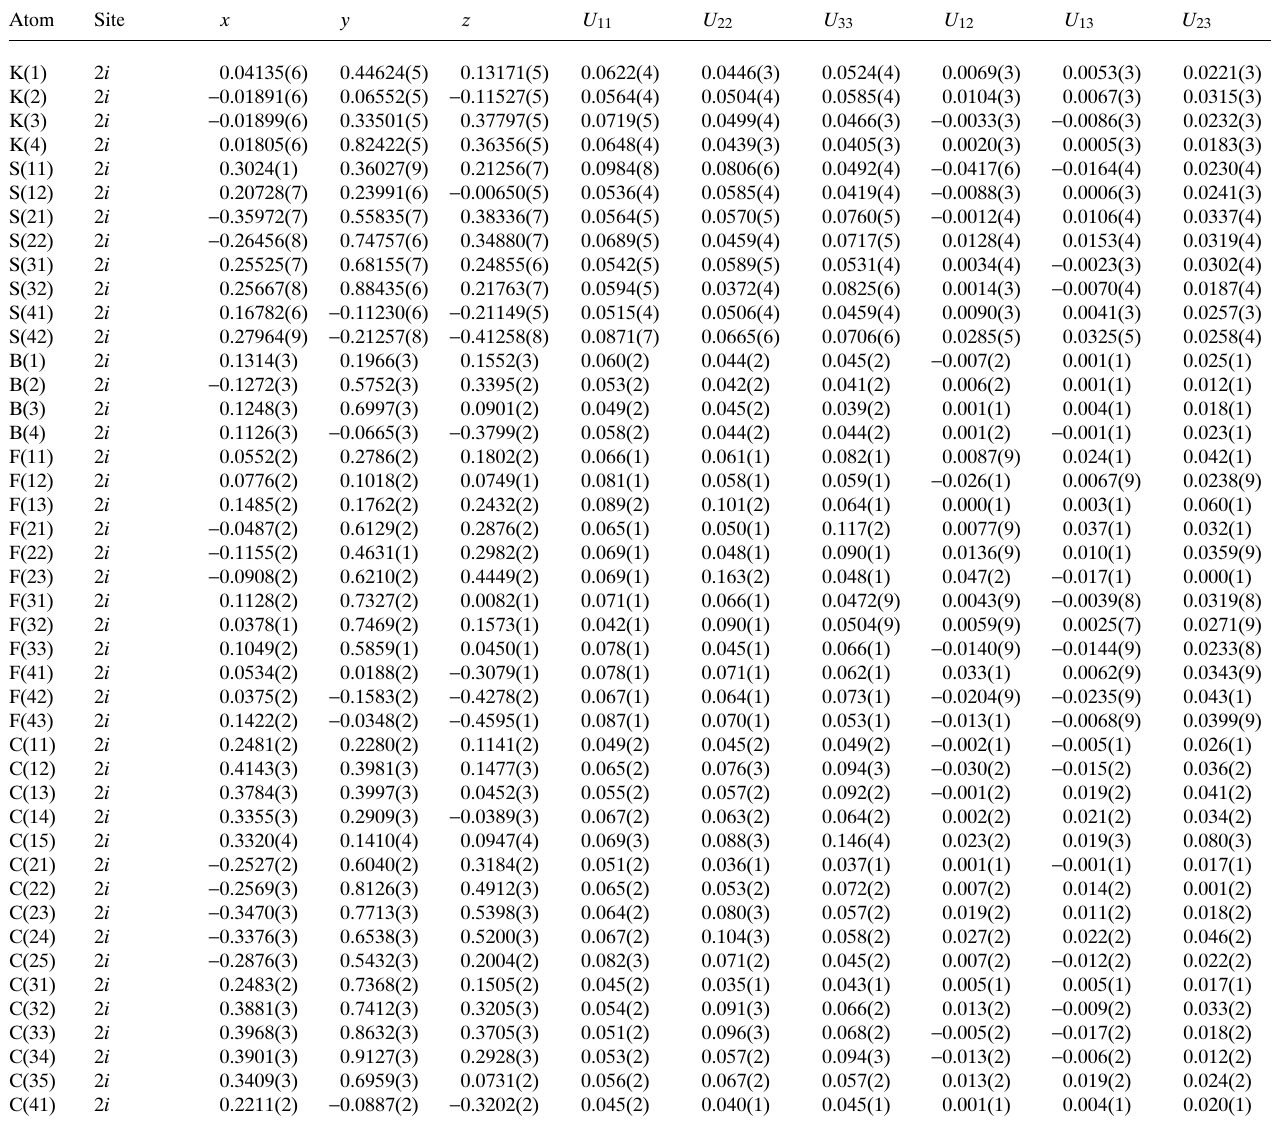
Table 3. Atomic coordinates and displacement parameters (in Å 2 ) .